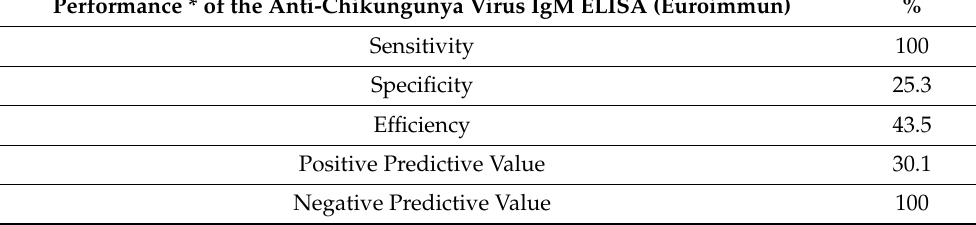
Table 2. Overall performance of the anti-chikungunya IgM ELISA (Euroimmun) for chikungunya diagnosis in